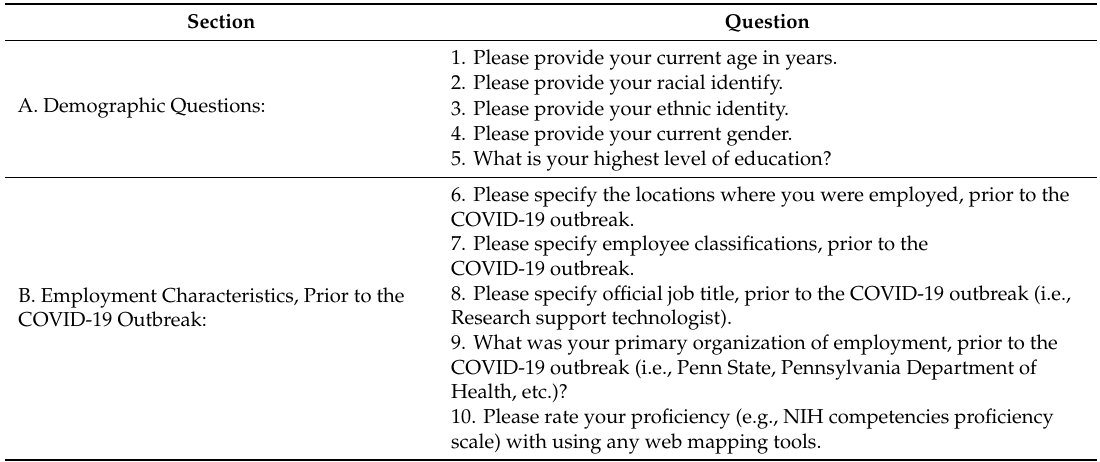
Table A1. LionVu 2.0 Usability Survey